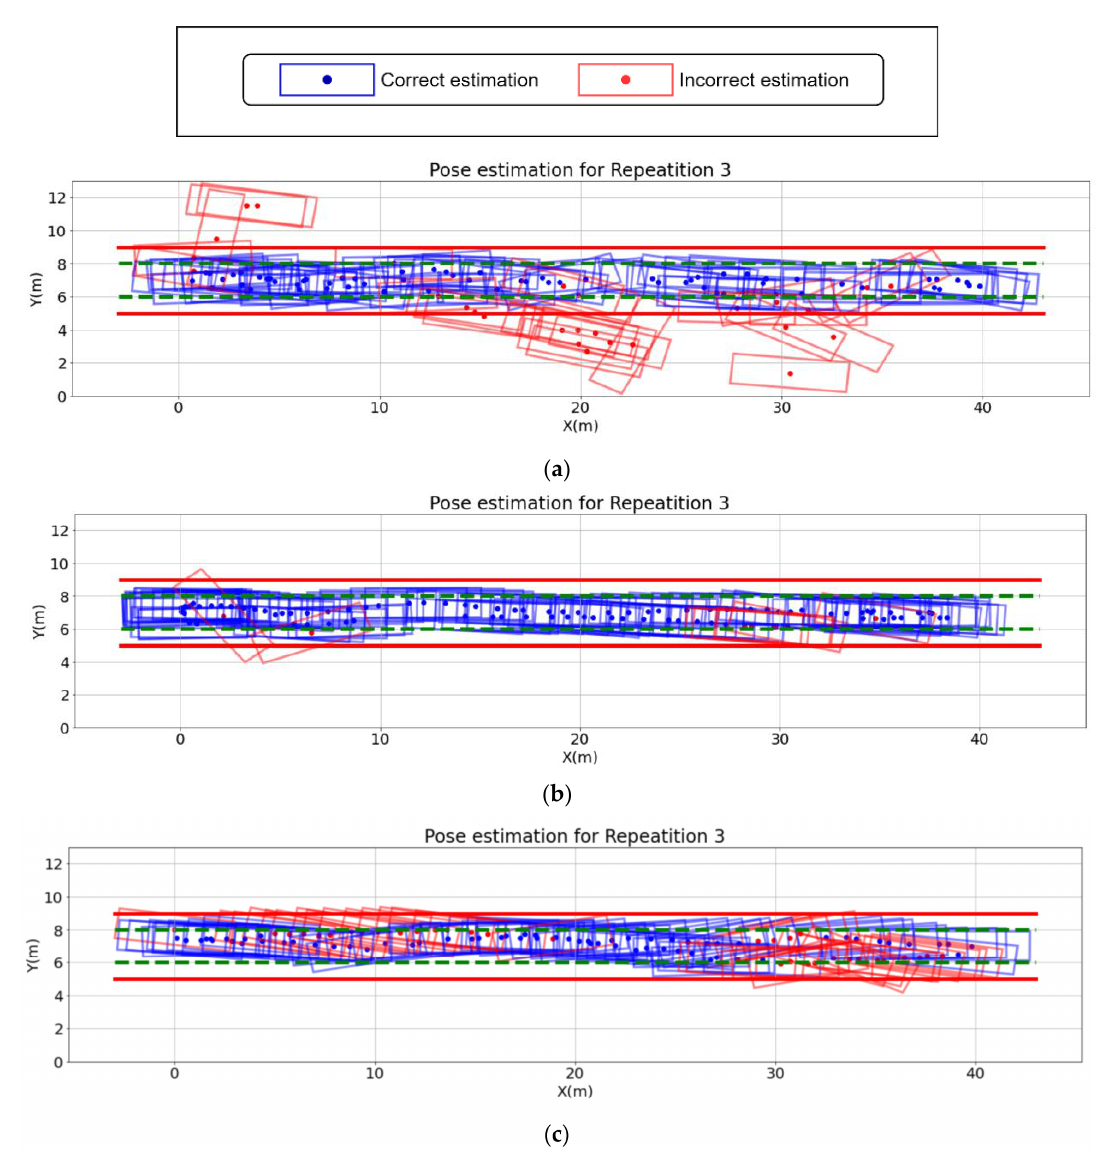
Figure 10. Pose estimation output for repetition #3 of LOS scenario ( a ) baseline, ( b ) ViPER, and ( c ) ViPER+.